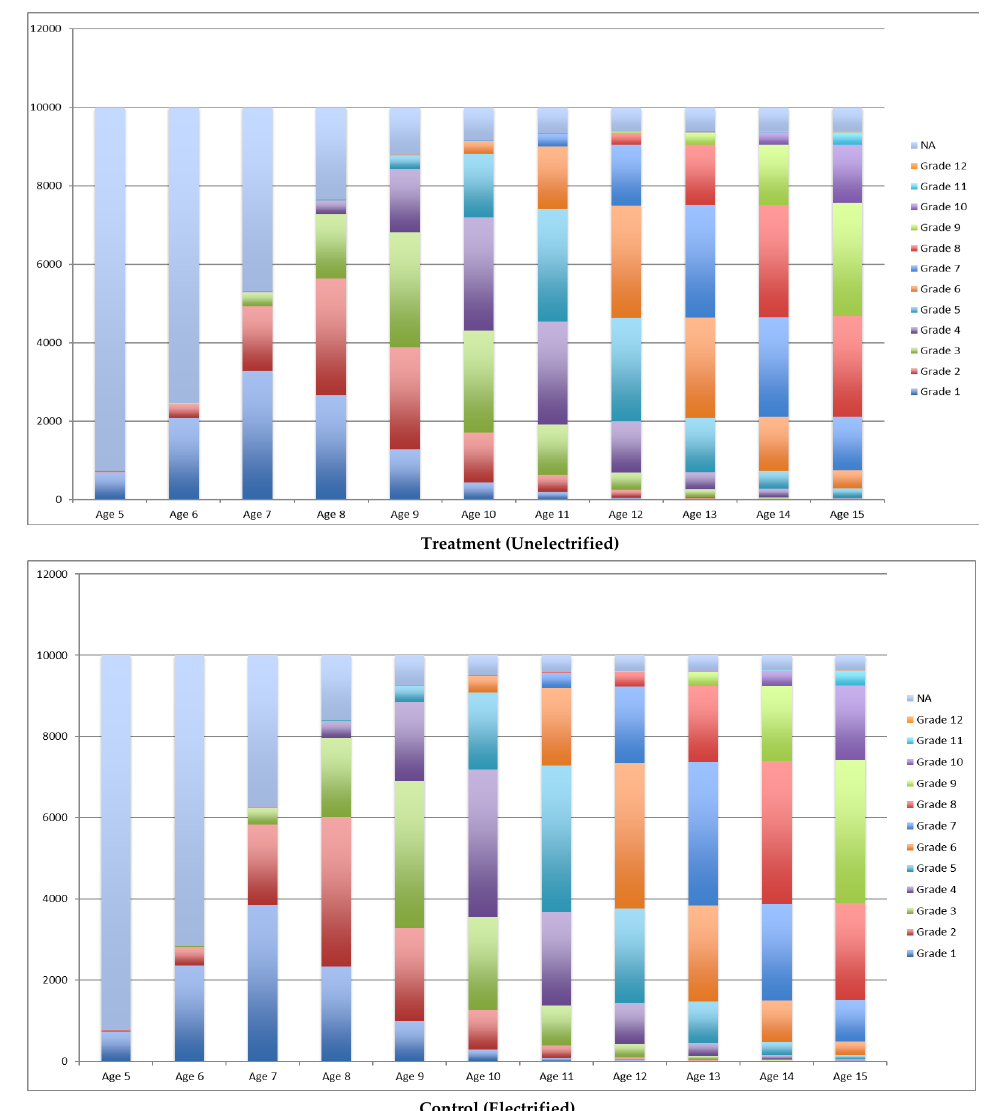
Table 7. Grade distribution at age 5.